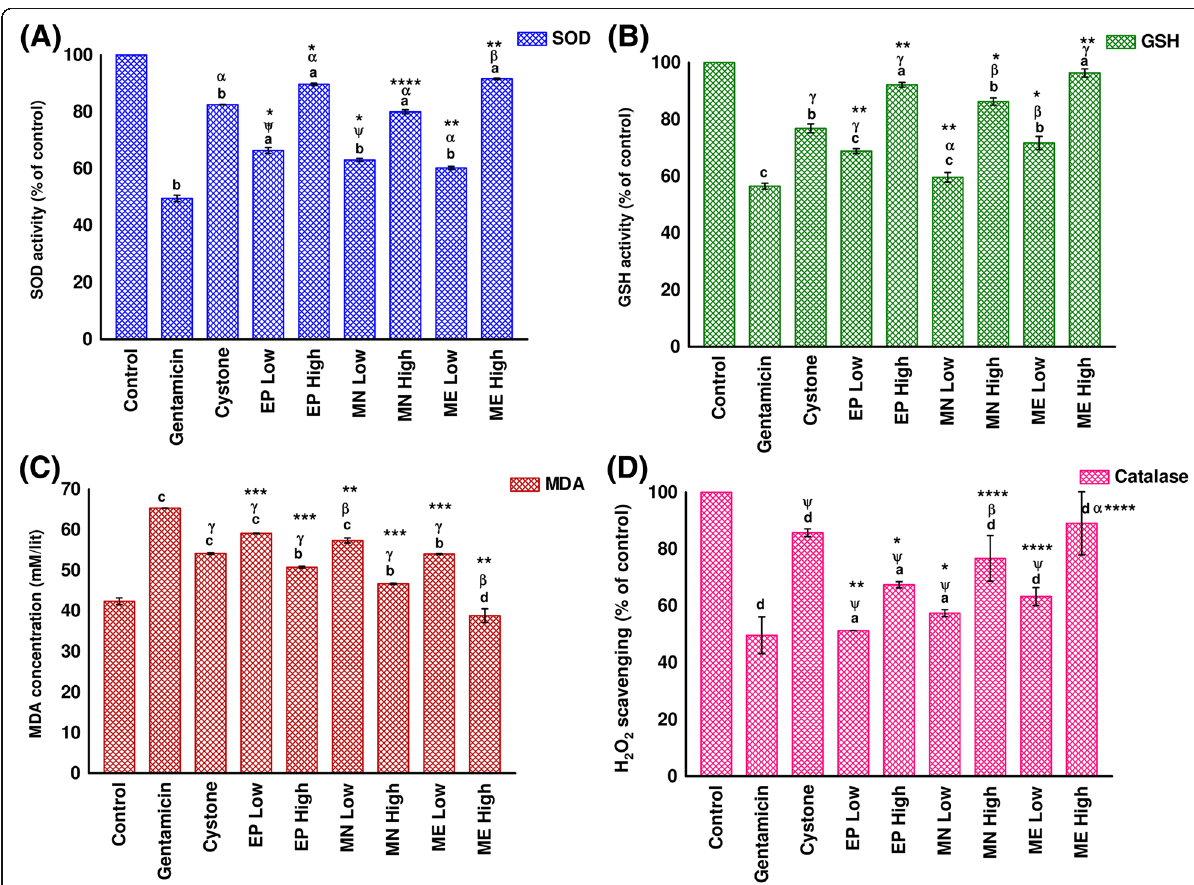
Fig. 2 The effect of three actinorhizal fruits on a Superoxide Dismutase (SOD) activity, b Reduced Glutathione (GSH) activity, c Lipid Peroxidation (MDA) activity, d Catalase activity. Data expressed as mean±S.D. ( n =6). a p <0.05; b p <0.01; c p <0.001; d p=non significant vs control group; α p <0.05; β p <0.01; γ p <0.001; ψ p =non significant vs gentamicin group; * p <0.05; ** p <0.01; *** p <0.001; ****p=non significant vs cystone